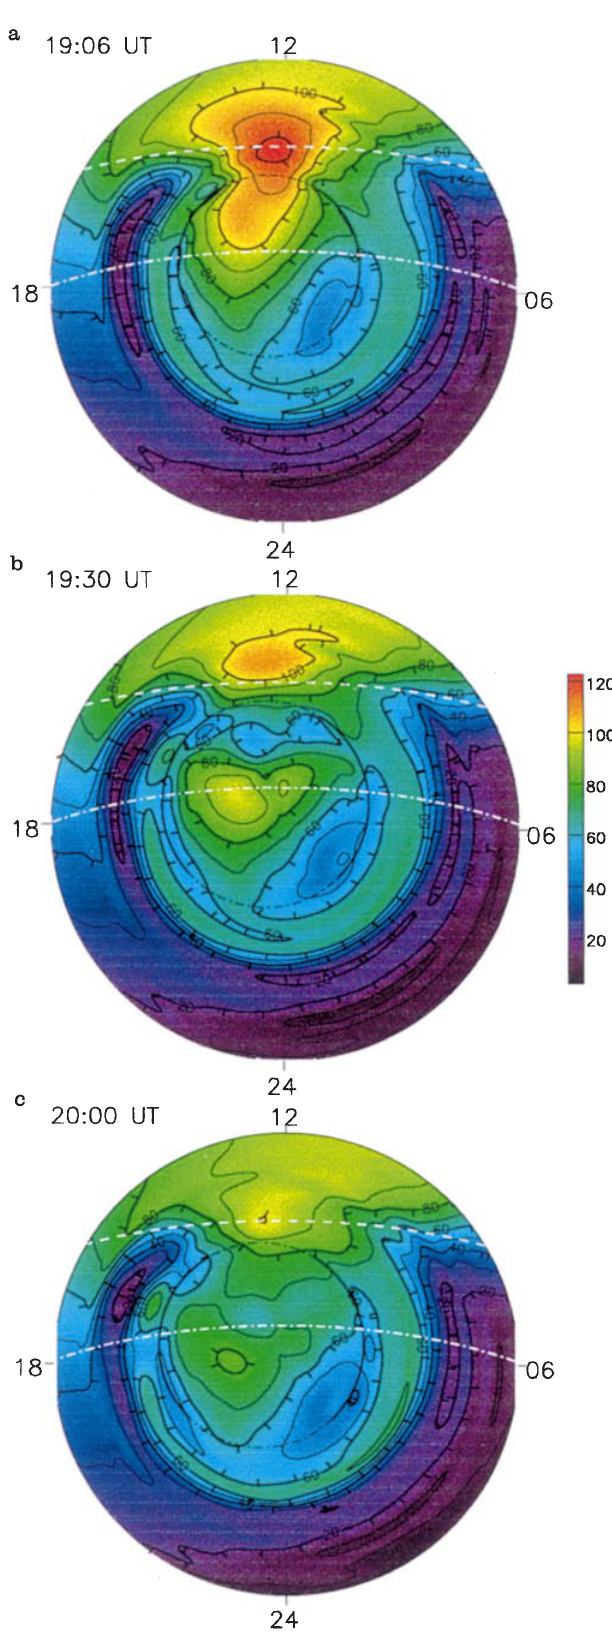
Fig. 2a–c. Polar plots of NmF2 down to a latitude of 50 (cid:14) at a 1906 UT, b 1930 UT c 2000 UT. NmF2 values in units of 10 10 m (cid:255) 3 are shown by the colour bar . NmF2 values are also indicated by the plotted contours . Bold contours are at intervals of 20 (cid:2) 10 10 m (cid:255) 3 . The tickmarks show the direction in which NmF2 decreases. The bold circle shows the polar cap boundary. The positions of the terminators at the ground and at 300 km are marked by white dashed and dot- dashed lines respectively